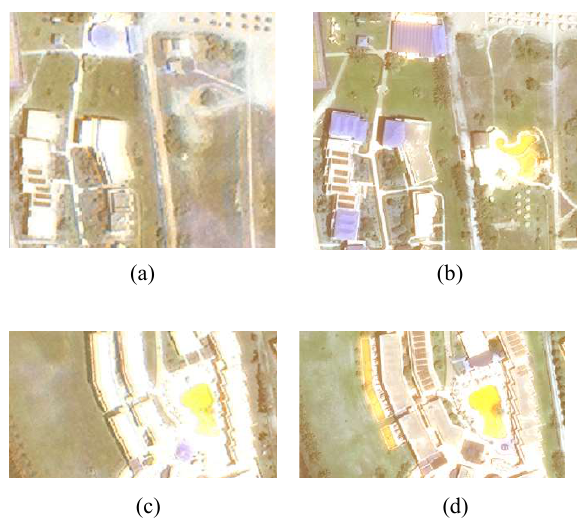
Figure 1 . (a) QuickBird image of “Scene 1” at spatial resolution 30 cm/pixel resulting from bicubic interpolation performed on the original one of resolution 60 cm/pixel. (b) WorldView image of “Sce ne 1” at spatial resolution 30cm/pixel. (c)